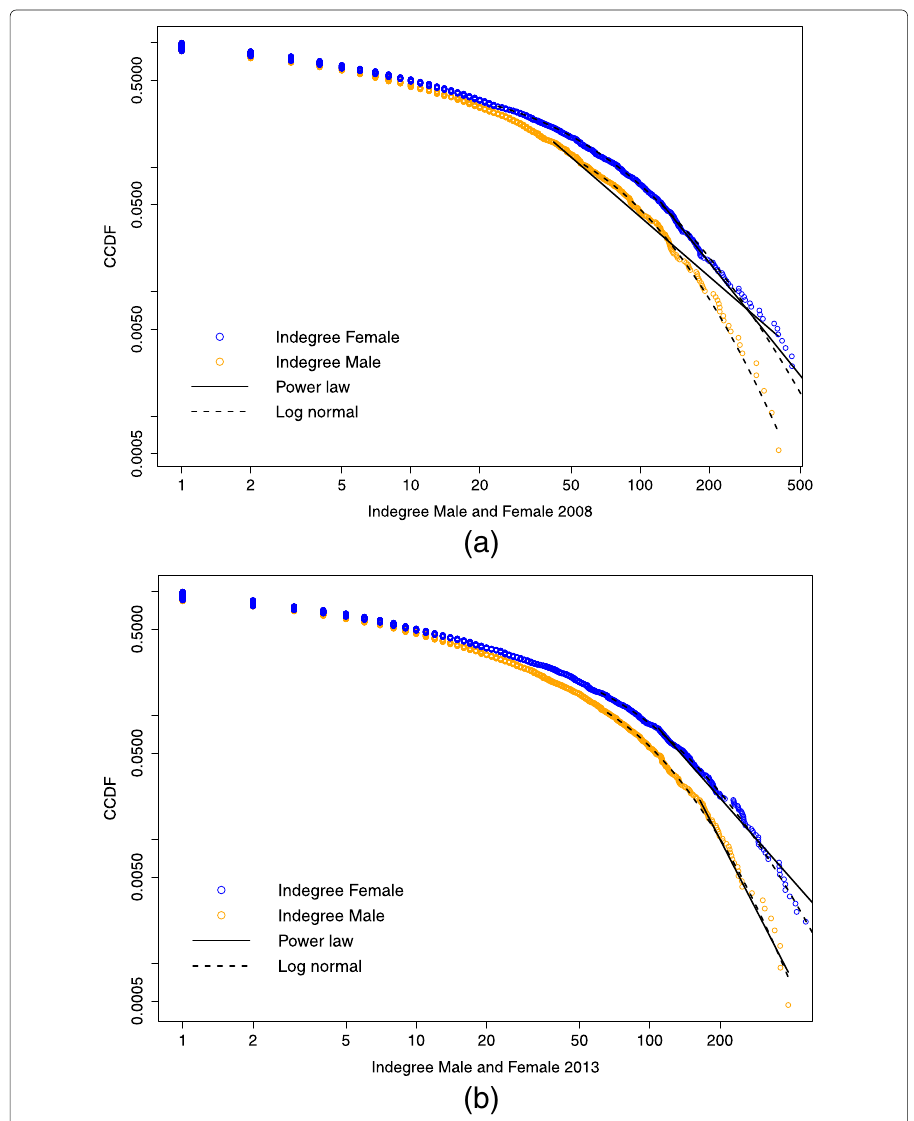
Fig. 9 2008 and 2013 indegree distributions compared by gender. Complementary cumulative distribution function (CCDF) on log-log scale of the female and male indegree distribution for the years 2008 (a) and 2013 (b). For each empirical distribution, the plots display also the lines of fit for a power law and a lognormal distributional